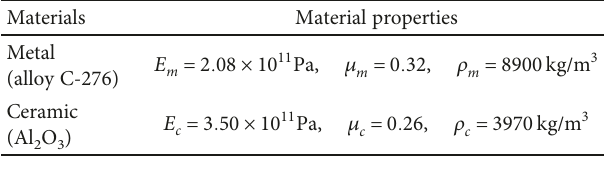
Table 4: The materials and properties of the FG sandwich